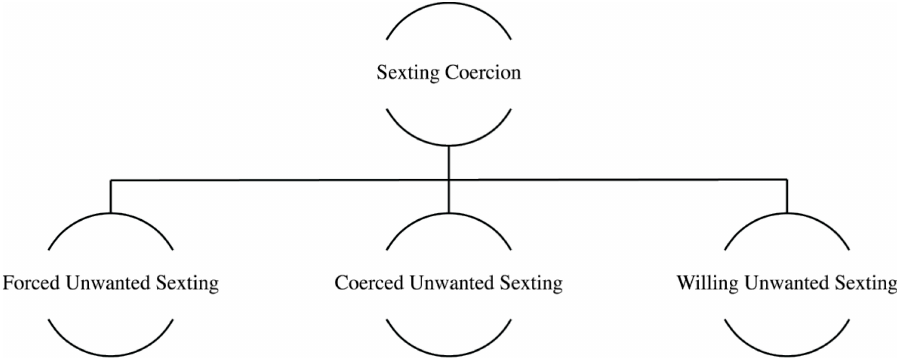
Figure 1. Categories of sexting coercion. Note: Adapted from [23].